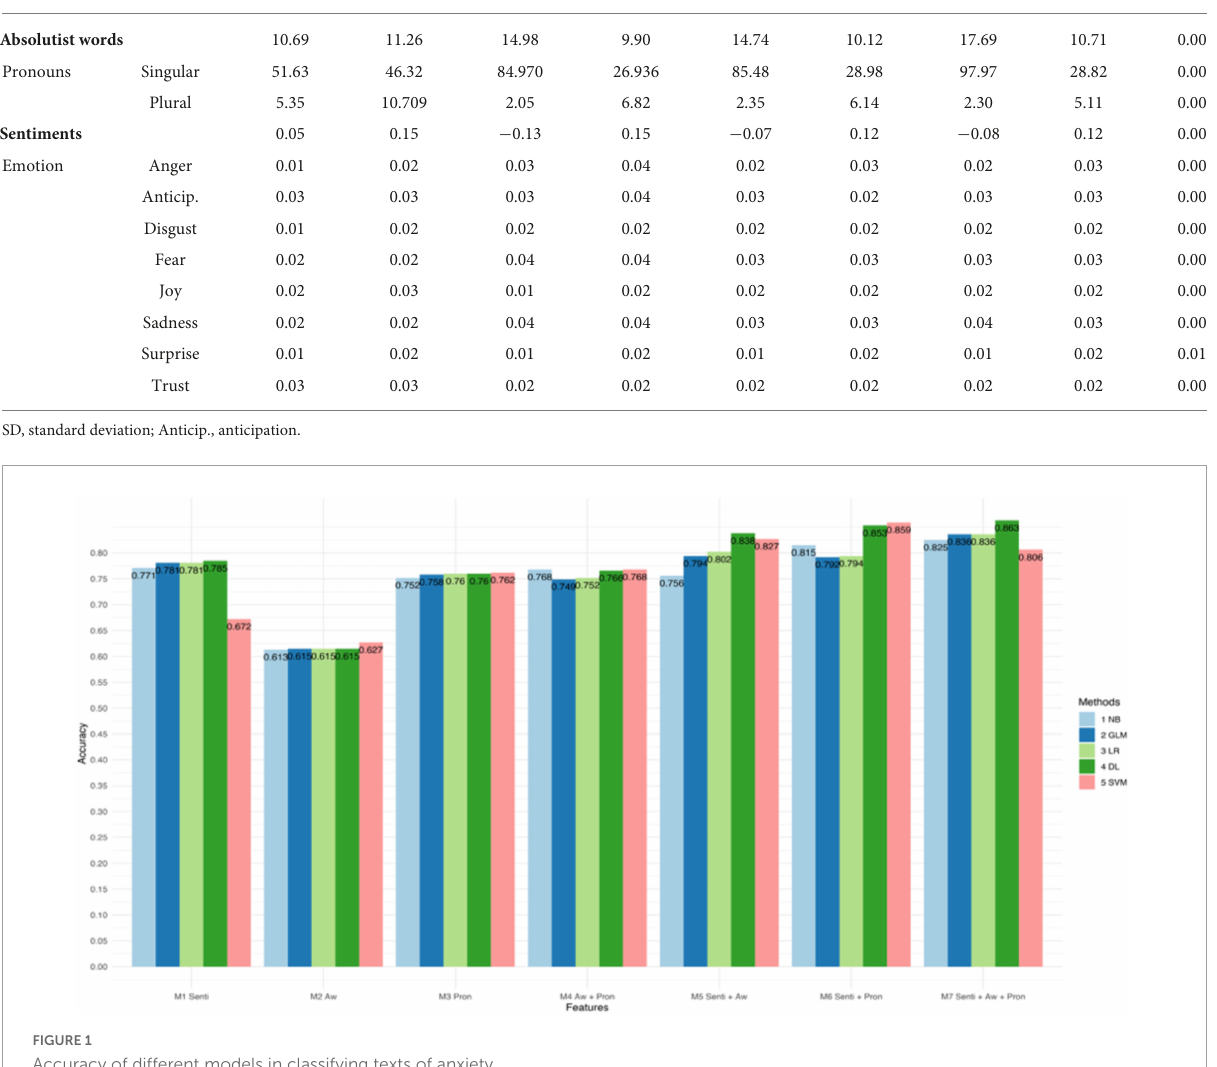
results show some interesting findings. First, absolutist words yielded the lowest performance in detecting psychological states. Specifically, it achieved 62.7% accuracy with SVM in anxiety, 65.8% accuracy with Logistic Regression in depression, and 74.4% accuracy with Deep Learning in suicide